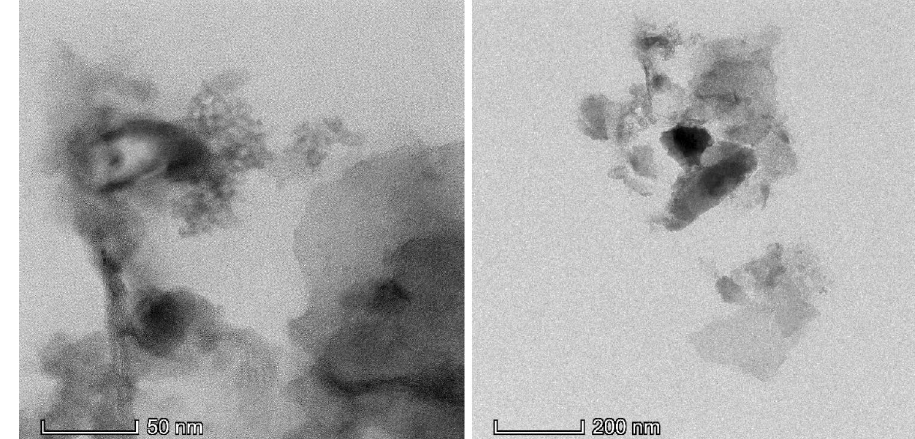
Figure 6. TEM micrographs of GSC WCO .